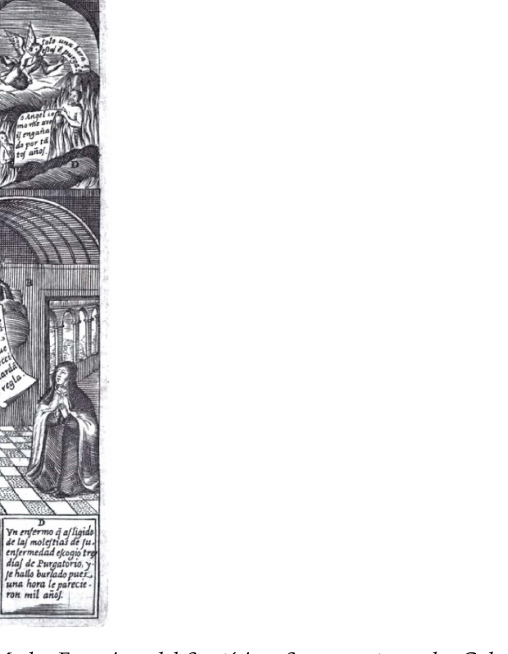
Figure 14. Quart. Venerable Madre Francisca del Sant í simo Sacramento; padre Gabriel de la Asunci ó n y madre Ana de San Agust í n . Francisco de la Cruz, Cinco palabras del ap ó stol San Pablo . . . p.